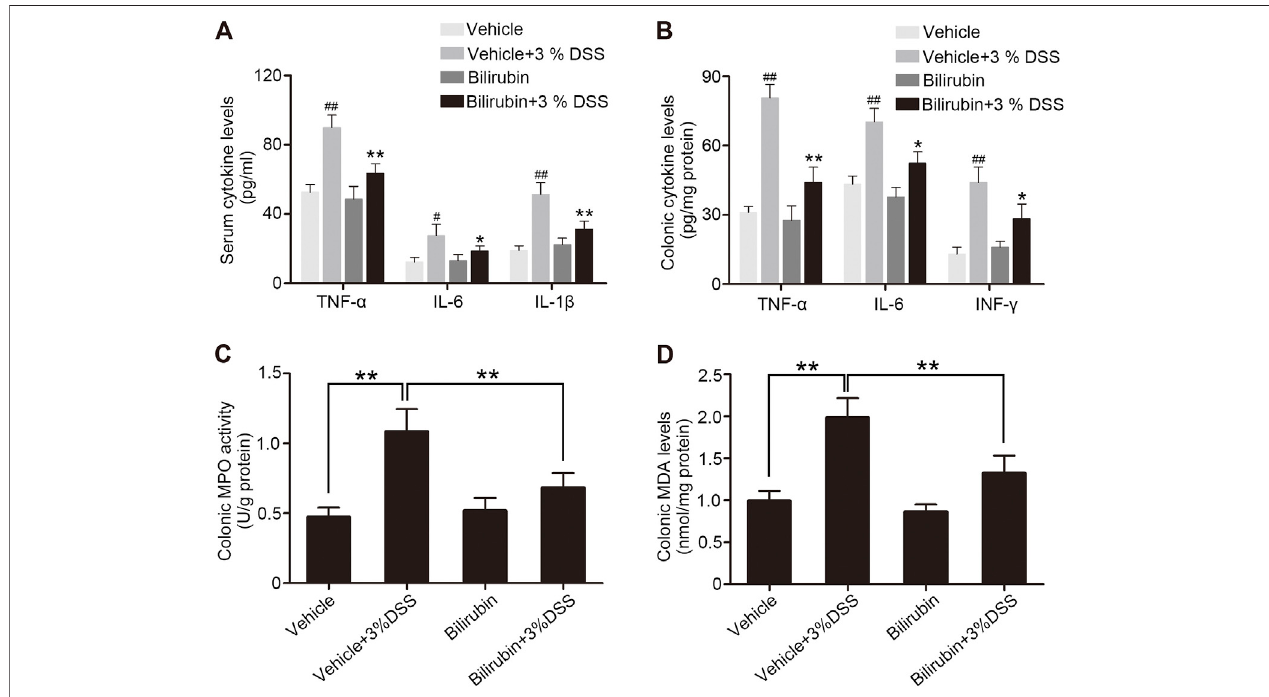
FIGURE2| UCBalleviatesin fl ammationinthecolonofDSS-treatedmice. (A) SerumlevelsofTNF- α ,IL-6andIL-1 β intheindicatedgroups.Dataareexpressedas mean ± SEM ( n (cid:2) 6). * p < 0.05 and ** p < 0.01 vs. the colitis group. # p < 0.05 and ## p < 0.01 vs. the vehicle group. (B) TNF- α , IL-6 and IFN- γ levels in the colonic homogenatesfromtheindicatedgroups.Dataareexpressedasmean ± SEM( n (cid:2) 6).* p < 0.05and** p < 0.01 vs. thecolitisgroup. ## p < 0.01 vs. thevehiclegroup. (C,D) Colonic MPO activity and MDA levels in the indicated groups. Data are expressed as mean ± SEM ( n (cid:2) 6); ** p <